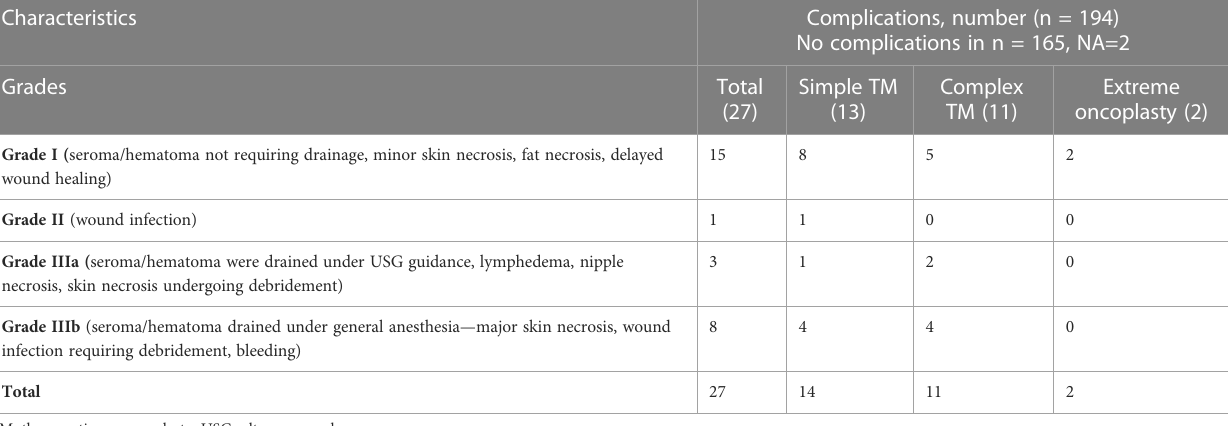
TABLE 6 Post-op complications in the cohort as per the Clavien – Dindo classi fi cation.